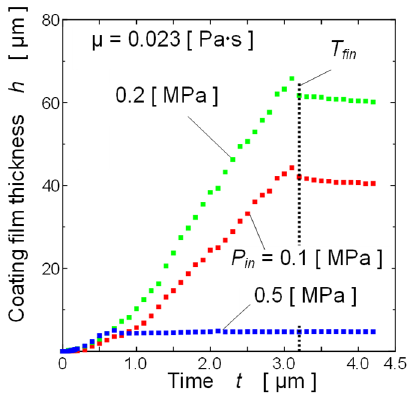
Figure 14. Coating film thickness under various injection pressures P in .